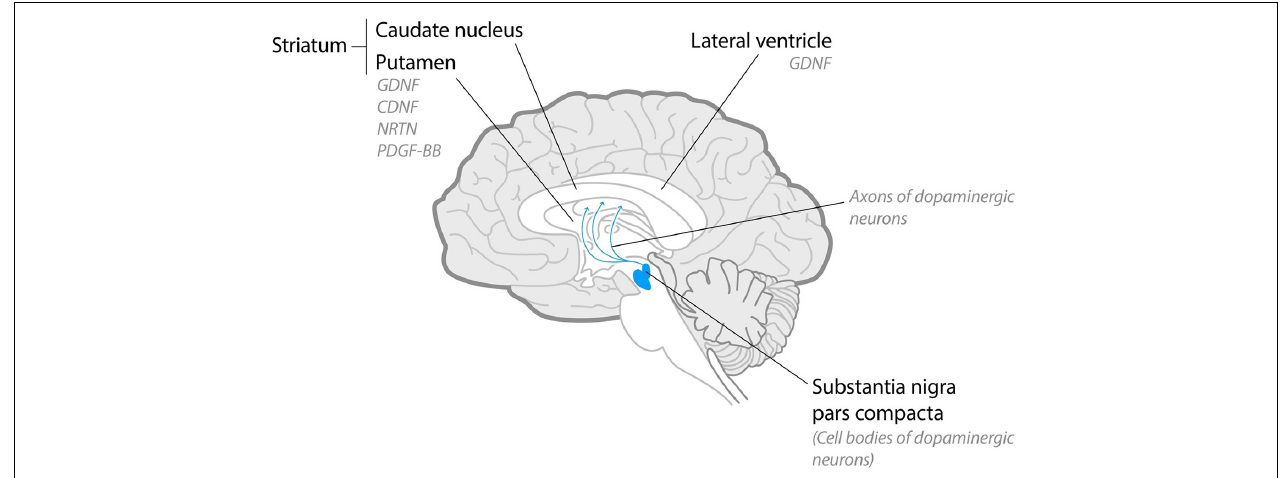
FIGURE 1 | Schematic midsagittal cross-section of the human brain. Dopaminergic neurons localize in substantia nigra pars compacta and project their axons into striatum. In clinical trials with PD patients NTFs were delivered intracranially into lateral ventricles (glial cell line-derived neurotrophic factor, GDNF) or, predominantly, into putamen [GDNF, neurturin (NRTN), platelet-derived growth factor (PDGF-BB) and cerebral dopamine neurotrophic factor (CDNF)].